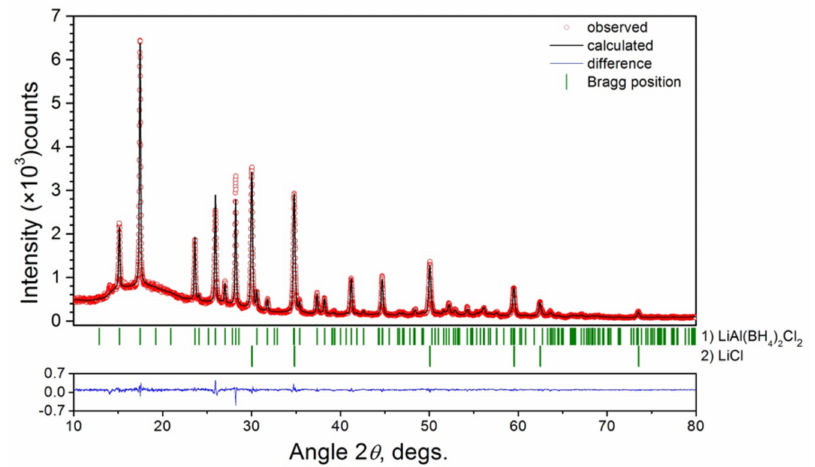
Figure 2. Rietveld-refined XRD pattern of the 2:1 (molar) mixture of LiBH 4 and AlCl 3 after 3 h of